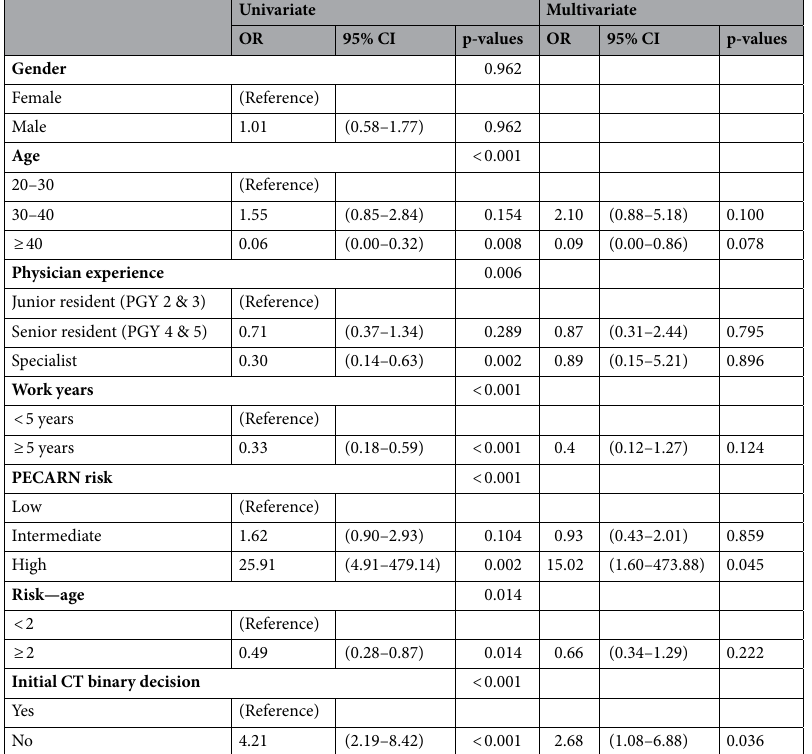
Table 3. Logistic regression analysis of factors affecting effectiveness of machine learning model to assist head CT order. PGY post graduate year.